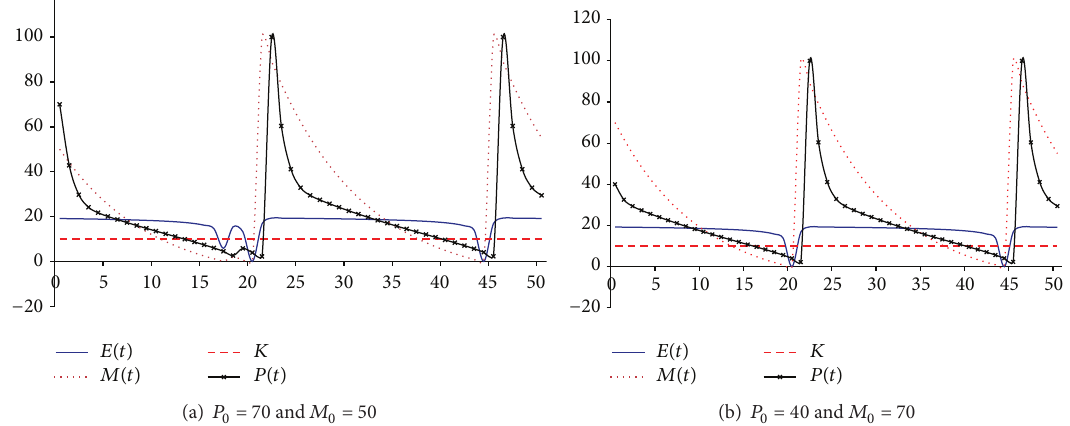
Figure 4: Behaviors of key attributes of system. Here, all the parameters and the initial states remain the same as the ones in Figure 2 for (a) and Figure 3 for (b). The time series graphs of 𝑃(𝑡) and 𝑀(𝑡) also clearly point out the cyclic pattern of the system behavior even though they look a little different in the first period due to different starting points. In both instances, the total marketing efforts 𝐸(𝑡) are higher than their optimal level 𝐾 most of the